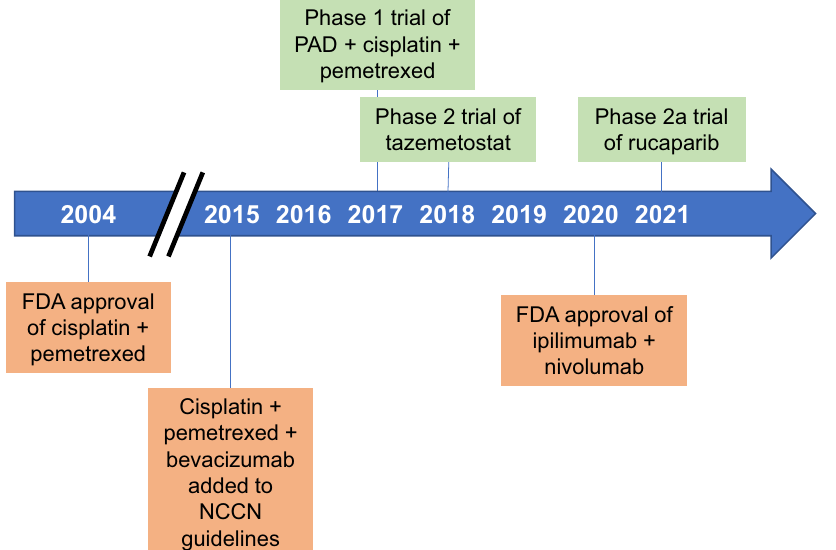
Fig. 1 Timeline of drug approvals/recommendations and personalized clinical trials in malignant mesothelioma. Genome-informed clinical trials are shown above the timeline in green. Drug approvals and recommendations are shown below the timeline in orange. FDA U.S. Food and Drug Administration, NCCN National Comprehensive Cancer Network, PAD pegylated arginine